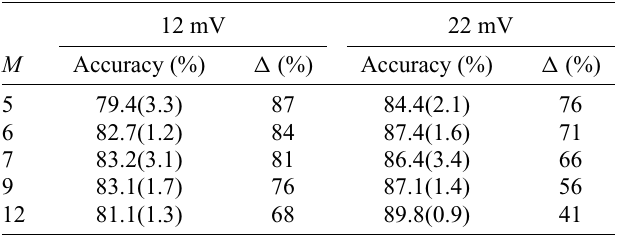
TABLE I. Summary of the performance for five M -projections for rays of length length 12 and 22 mV. The accuracy is aver- aged over N = 20 models, and the data reduction (cid:6) indicates the expected reduction in the number of measured points needed for classification compared with the CNN-based